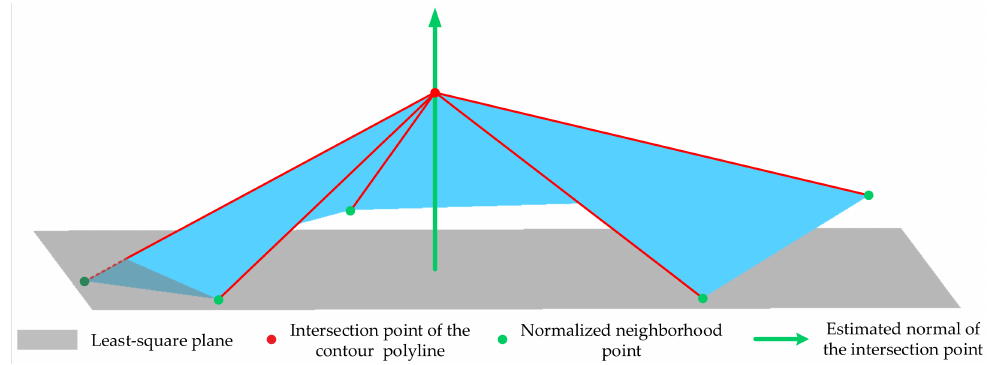
Figure 3. Normal estimation of the intersection